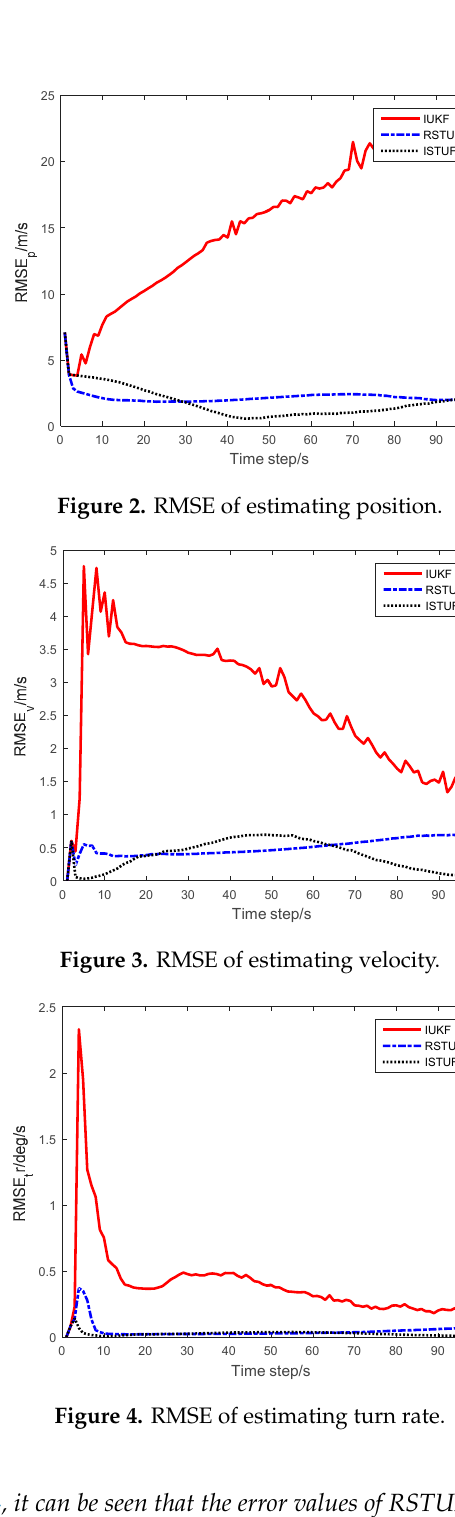
Figure 1. Comparison of the trajectories.